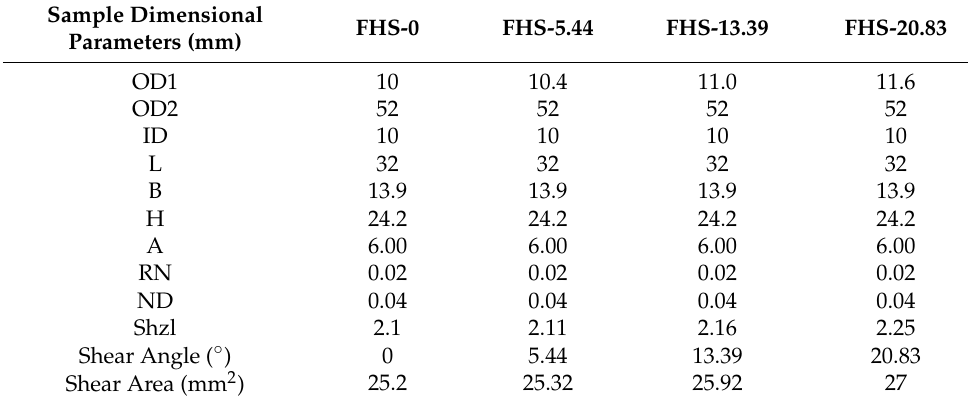
Table 2. Dimensional parameters utilized for shear specimens.